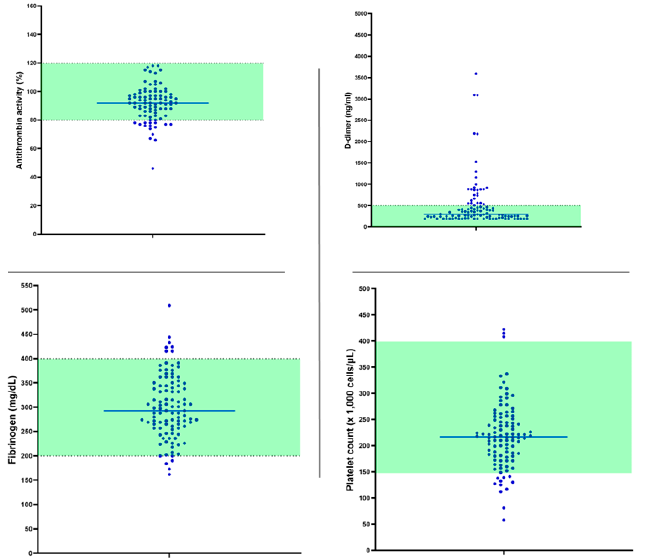
Figure 3. Individual and mean standard coagulation data at follow up. Green area is the normality range.